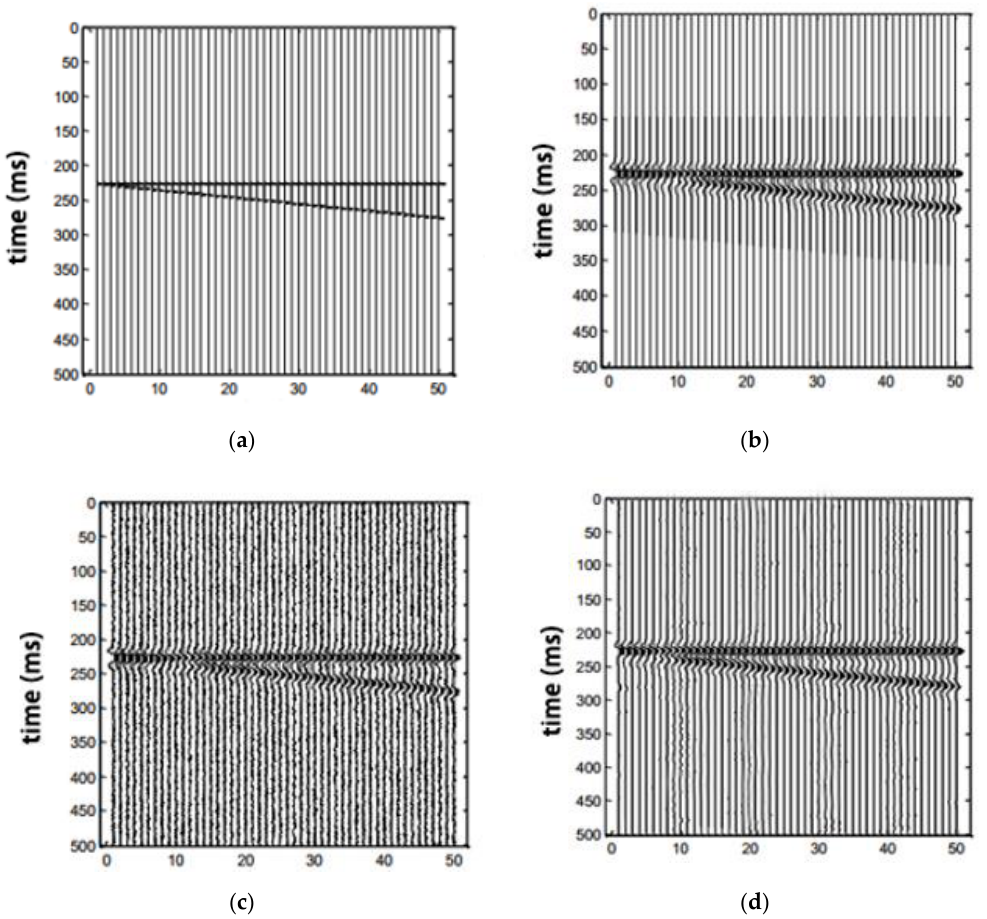
Figure 9. The chart of processed synthetic seismic data; ( a ) the profile of reflection coefficient; ( b ) the convoluted profile; ( c ) the profile after adding noise; ( d ) the processed profile by EMDNN method.